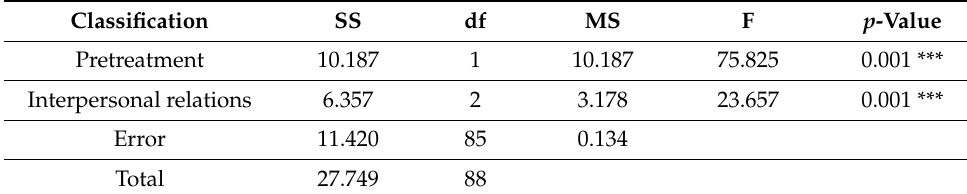
Table 5. The ANCOVA result of interpersonal relations.